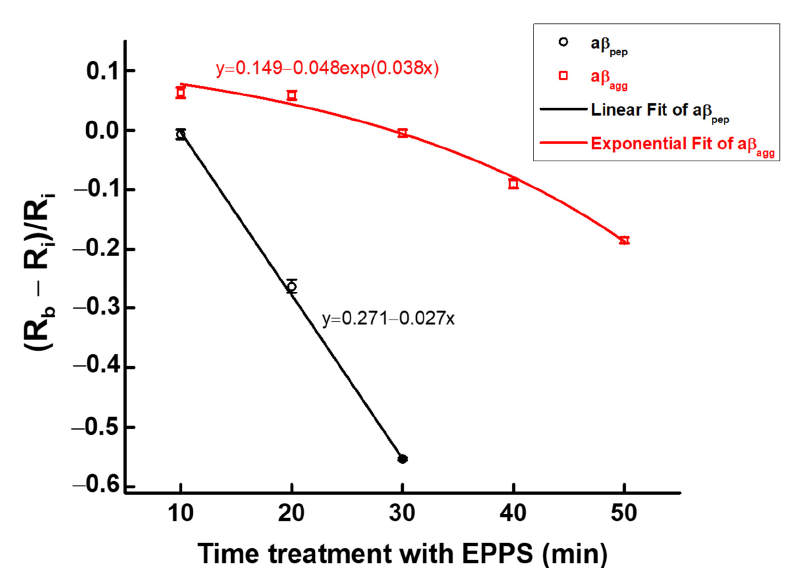
Figure 10. Fitting of two sets of disaggregation data for a β agg and a β pep , respectively; symbols and bars represent the average and standard deviation of the data (n = 3).